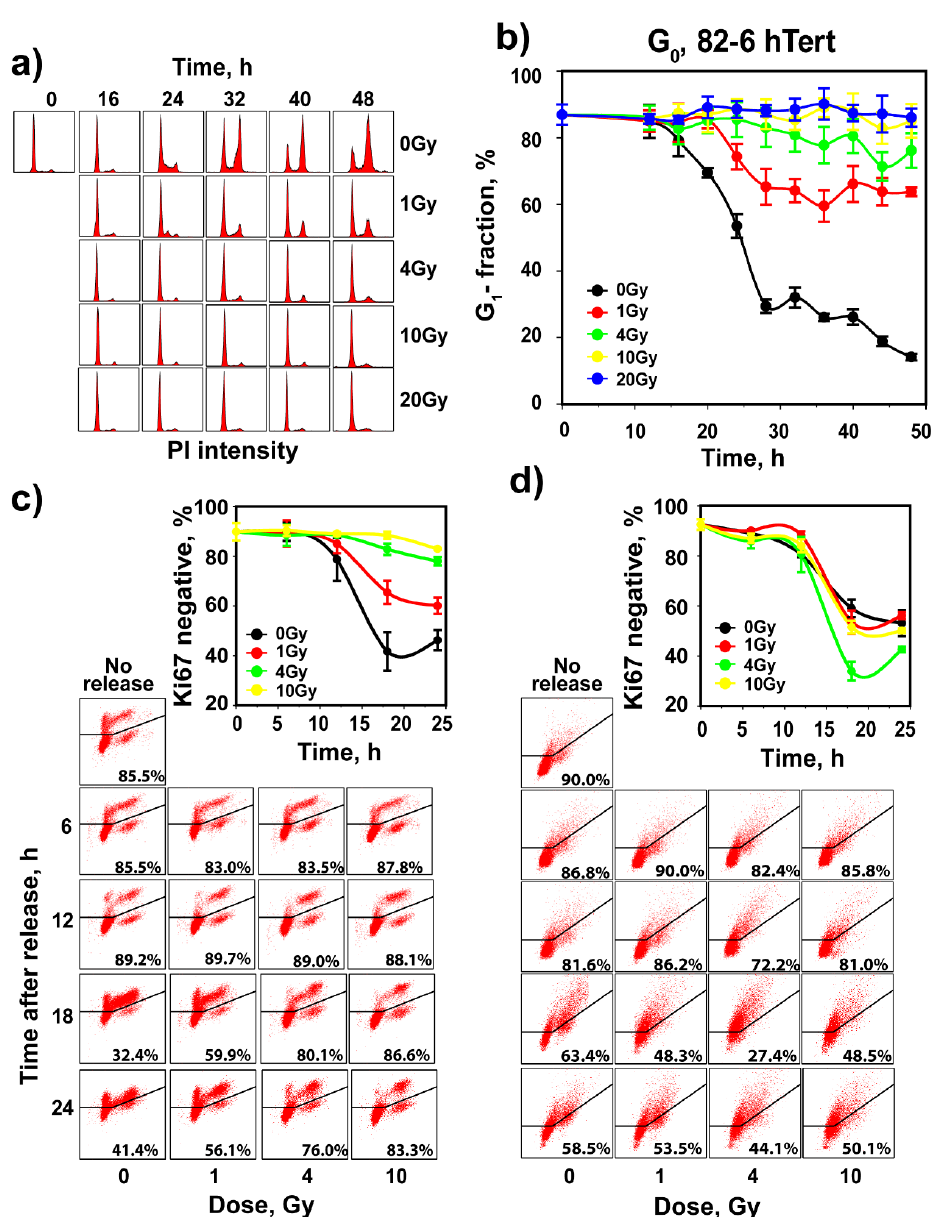
Figure 3. Assessment of G 1 checkpoint in irradiated G 0 cells of SD 82-6 hTert cell cultures. ( a ) His- tograms showing cell cycle distribution as a function of time after exposure to different doses of X-rays. Cells are transferred to complete growth medium supplemented with nocodazole just before irradiation. Owing to the addition of nocodazole in the growth medium, cell cycle progression causes a progressive enrichment in cells with G 2 /M DNA content. The reduction in the fraction of cells with G 0 /G 1 content as a function of time reflects the progression of G 0 cells into the S phase. Here again, the reduction in this rate reflects the activation of G 1 checkpoint. ( b ) As in Figure 1b for SD, 82-6 hTert cells exposed to the indicated doses of IR. ( c ) Analysis of Ki67 in the cell cultures analyzed in ( b ). ( d ) Analysis of pyronin Y in the cell cultures analyzed in ( b ). Plotted is the mean and SE from three independent experiments. See also Table S2 for more